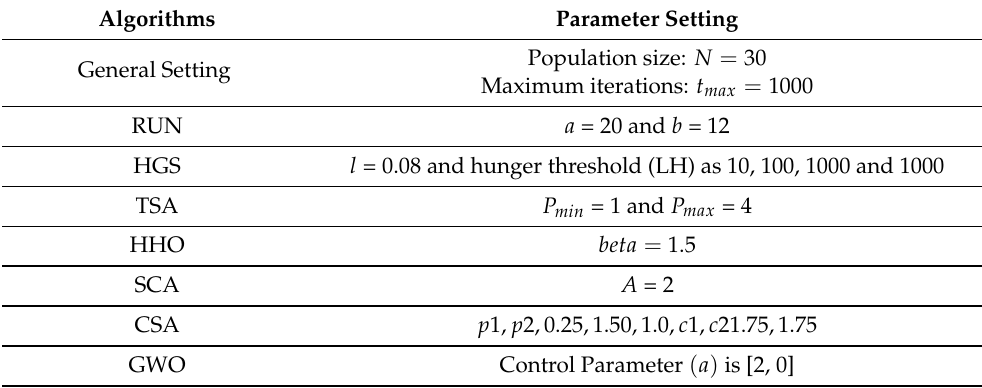
Table 2. Parameter setting for all the algorithms used in the comparative study.